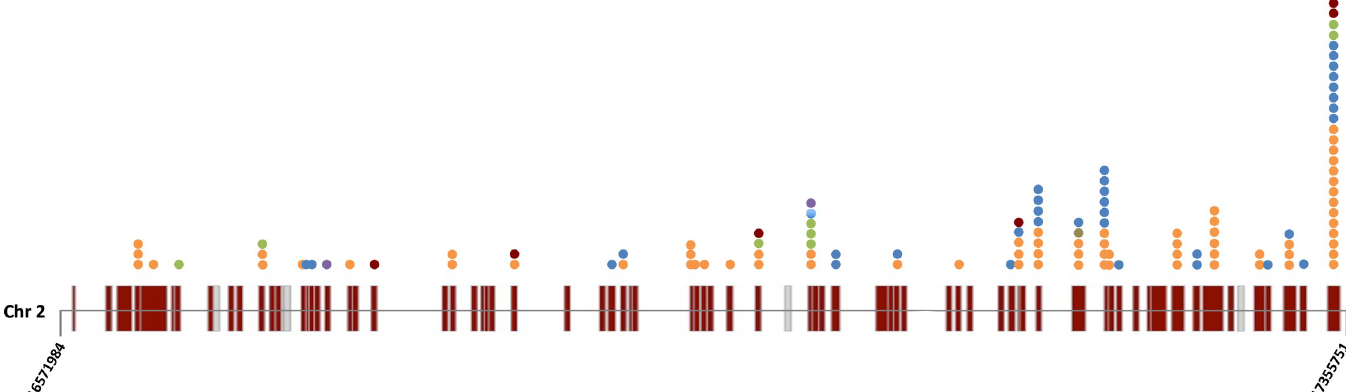
Fig 1. Polymorphisms between haplotypes H1 and H2 in the QTL_9 intragenic regions. Schematic view of the QTL_9 region with annotated genes. The genes which were captured for sequencing are indicated in brown and the non-captured genes in grey. The different polymorphic sites identified by gene capture within the genes between the haplotypes H1 and H2 are indicated by coloured dots, with a dot per polymorphic site: orange for non-synonymous coding, blue for synonymous coding, green for frame shift, purple for codon deletion, deep red for Stop gain and light brown for Start gain.